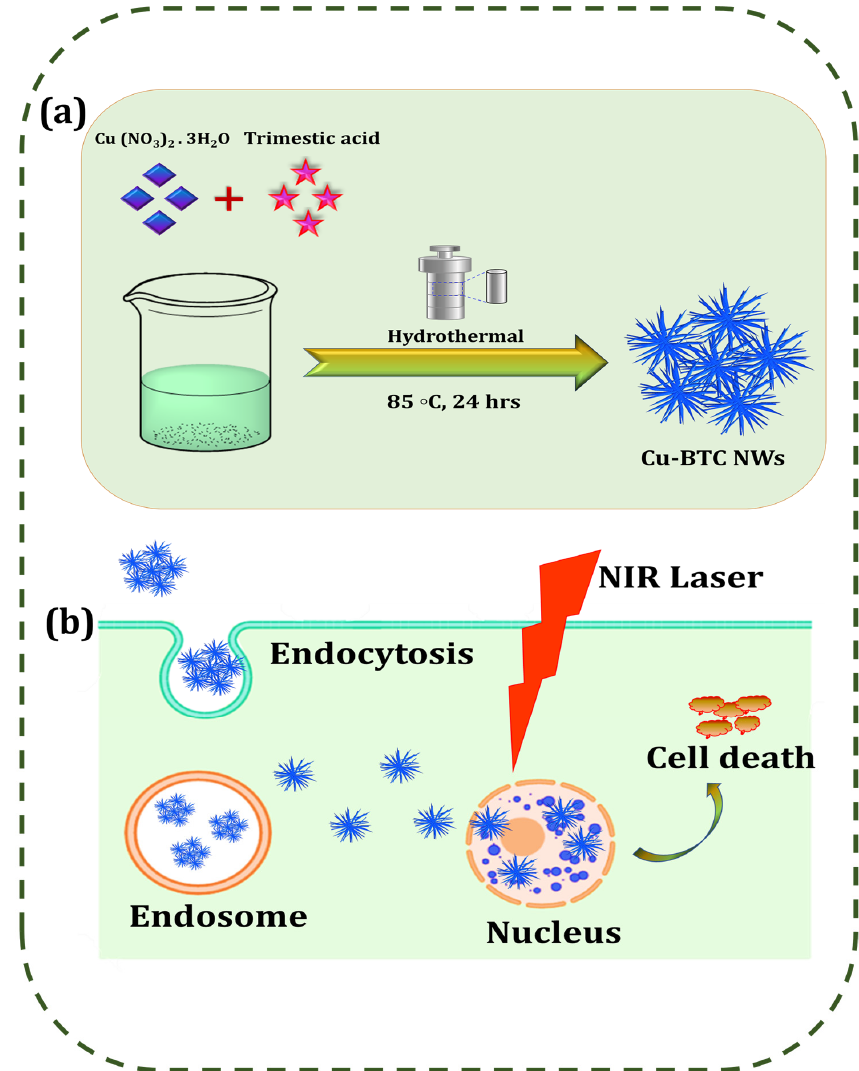
Scheme 1. Schematic illustration for the ( a ) synthesis of Cu-BTC NWs and ( b ) internalized mechanism of Cu-BTC NWs.